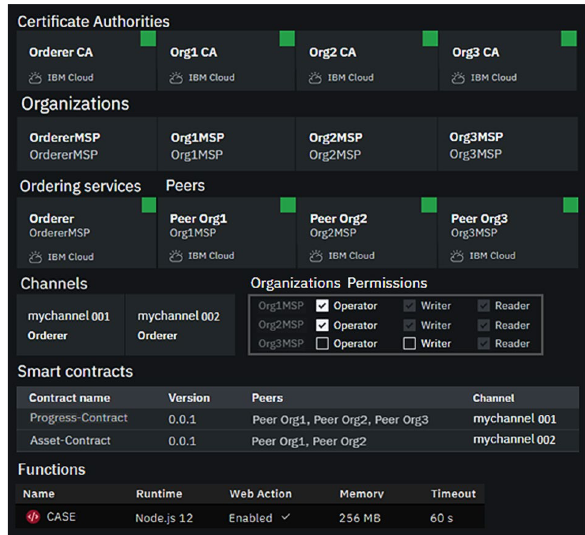
Figure 5. Blockchain network is